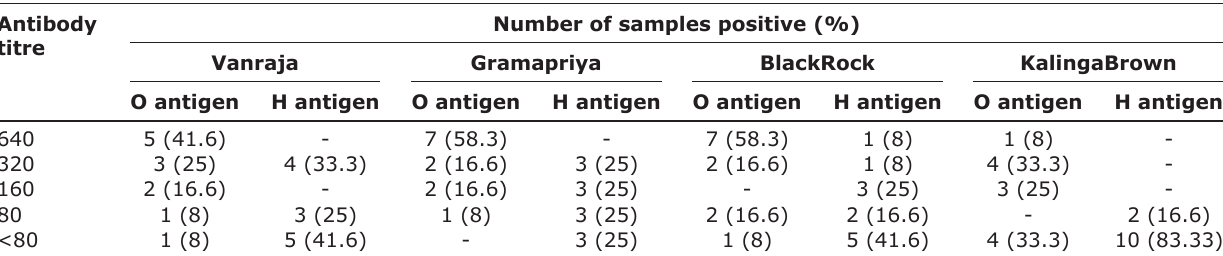
Table-6: Titer of specific antibodies against Salmonella in breeding hens in different breeds. Antibody